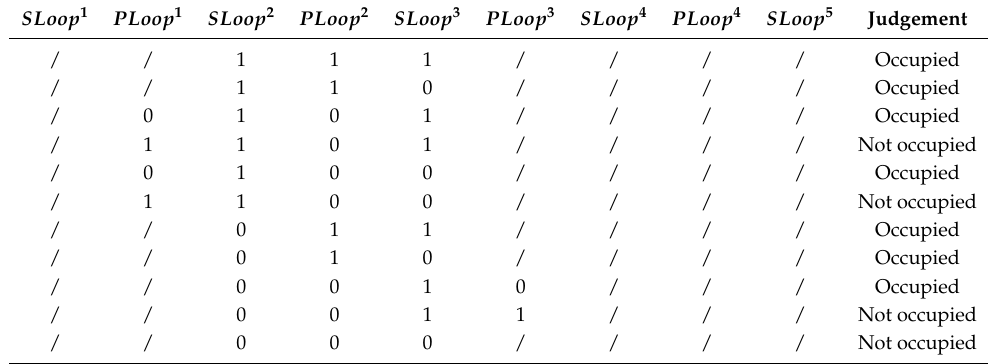
Table 5. Judgement of whether Lane 2 is